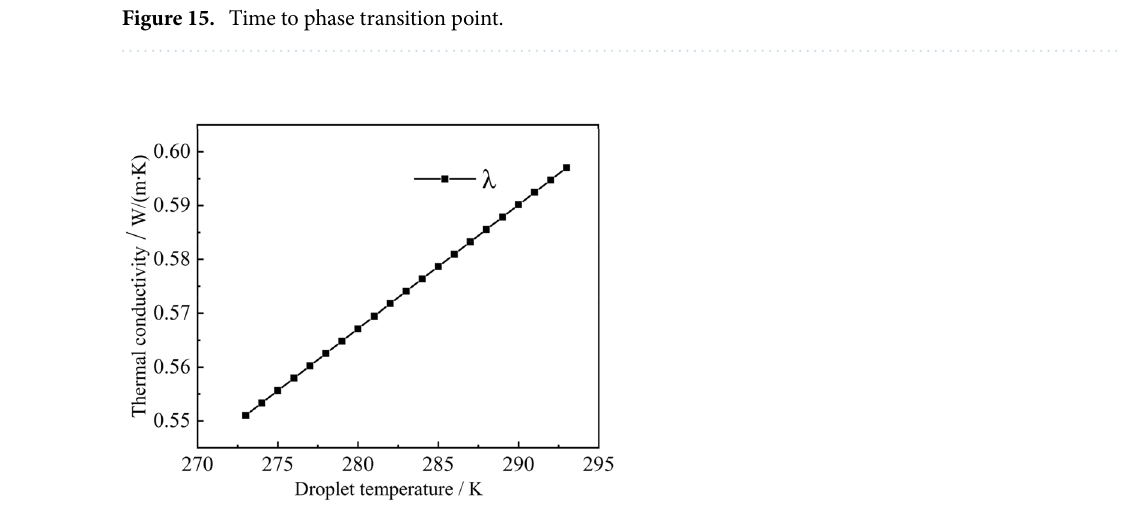
Figure 16. Thermal conductivity of droplets.